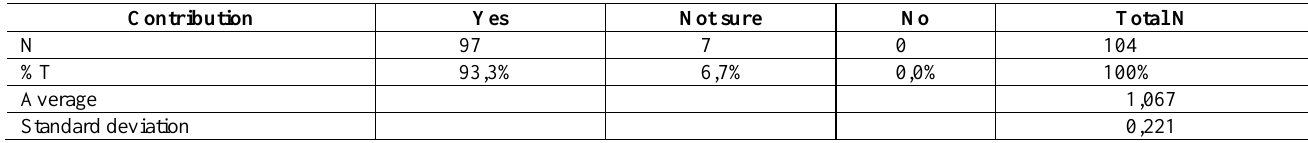
Table 3: Current strength and/or weakness in competitive operations priorities to compete nationally